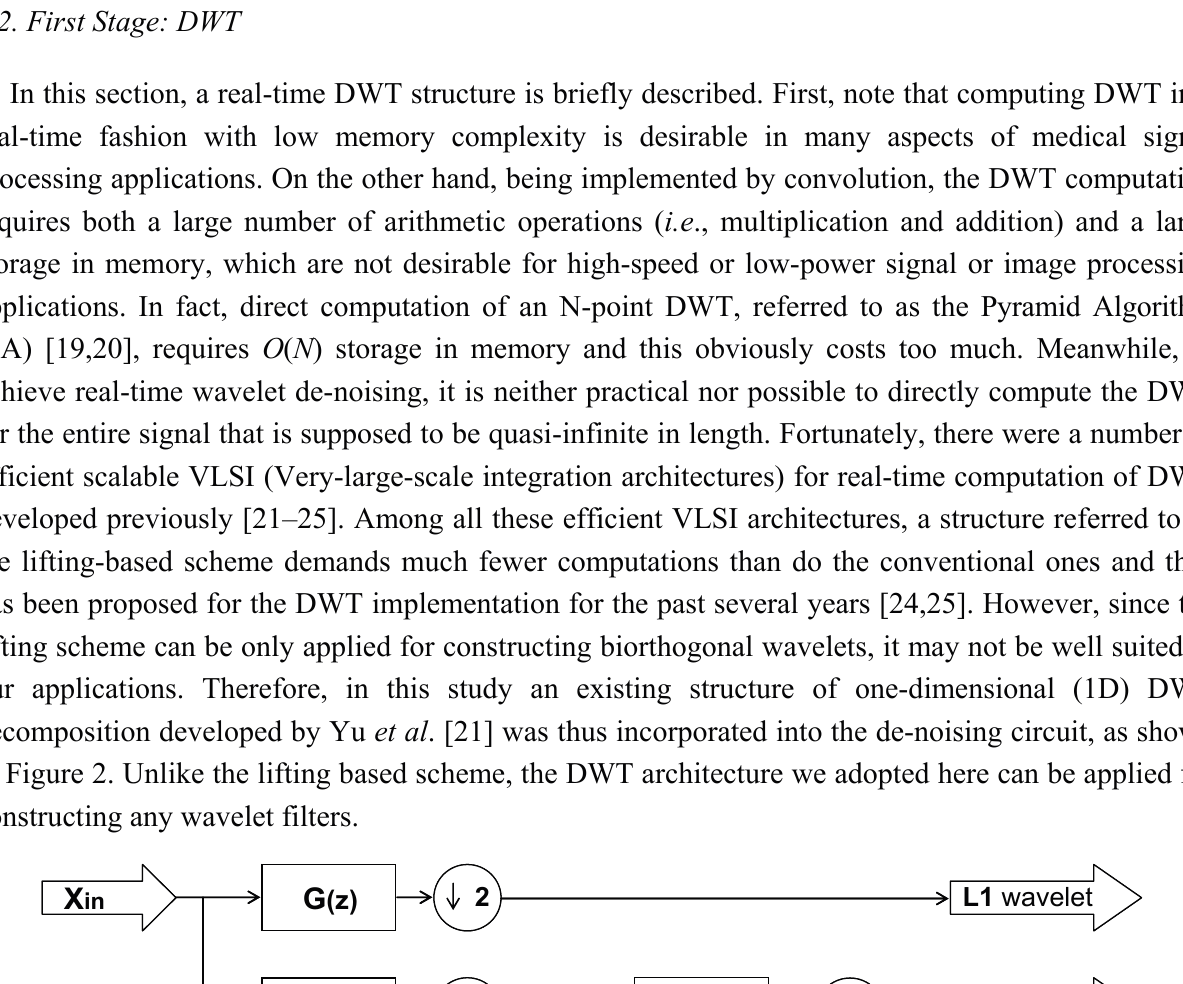
Figure 1. A schematic block diagram of the wavelet de-noising process.